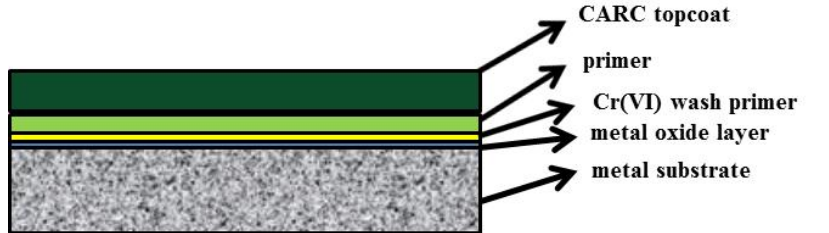
Figure 2. Schematic diagram of DOD Cr(VI)-based Army wash primer with military